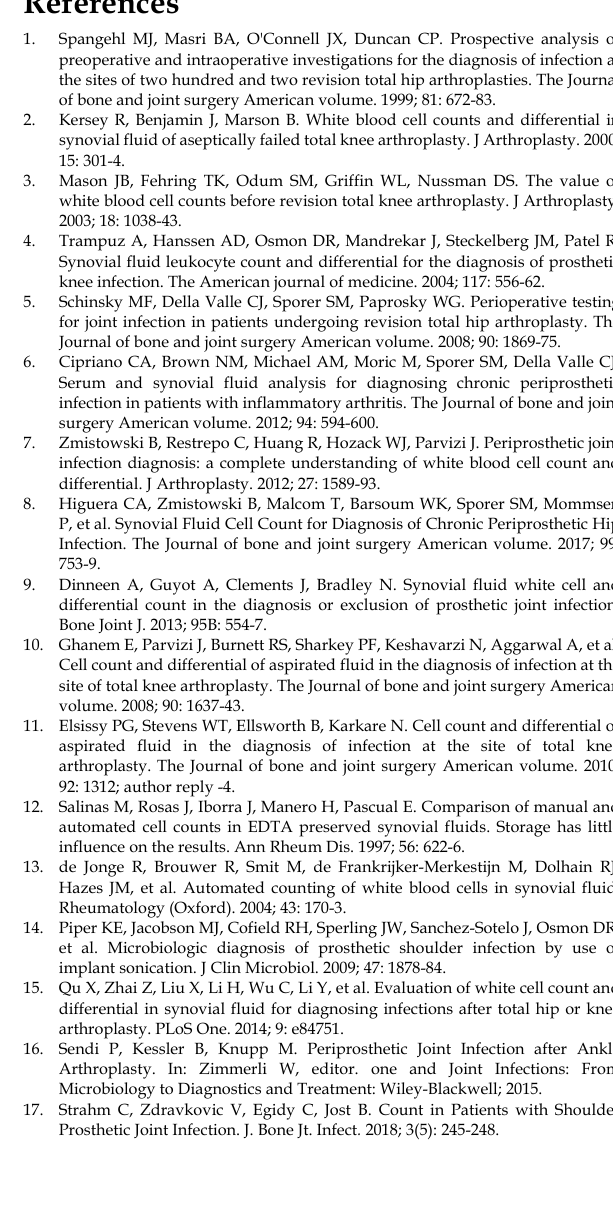
Footnotes: *When synovial cell count results was combined with an elevated erythrocyte sedimentation rate and C-reactive protein level, the optimal cut-off value was >3000 cells/ µ L. ┼ Study including 810 patients with noninflammatory a and 61 patients with inflammatory arthritis b . ‡ The study focusses on chronic PJI. & Cut-off defined prior to the study without ROC